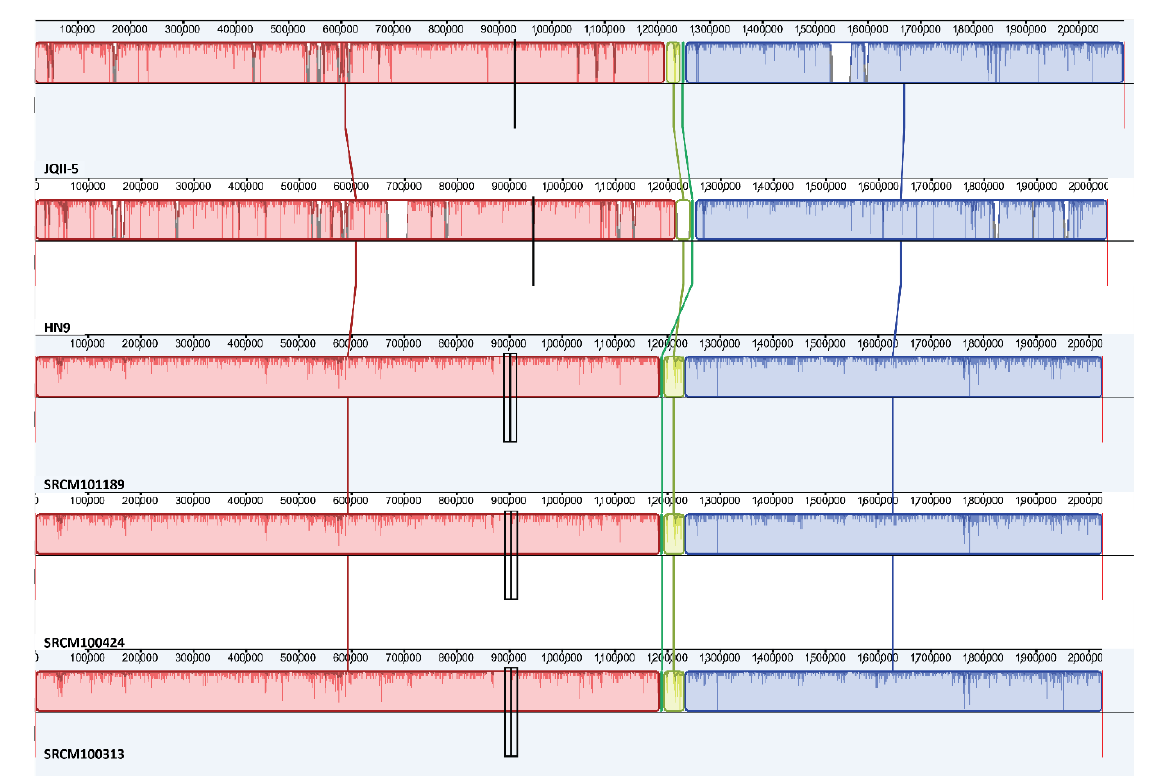
Figure 4. Multiple genome alignment of Pediococcus acidilactici strains, including HN9, JQII-5, SRCM100313, SRCM101189, and SRCM100424. Visualization of alignment is arranged into one horizontal panel per genome sequence, with the label of the genome sequence name on the bottom-left of each panel. The homologous blocks are represented with the same color and are connected within the genome by lines.